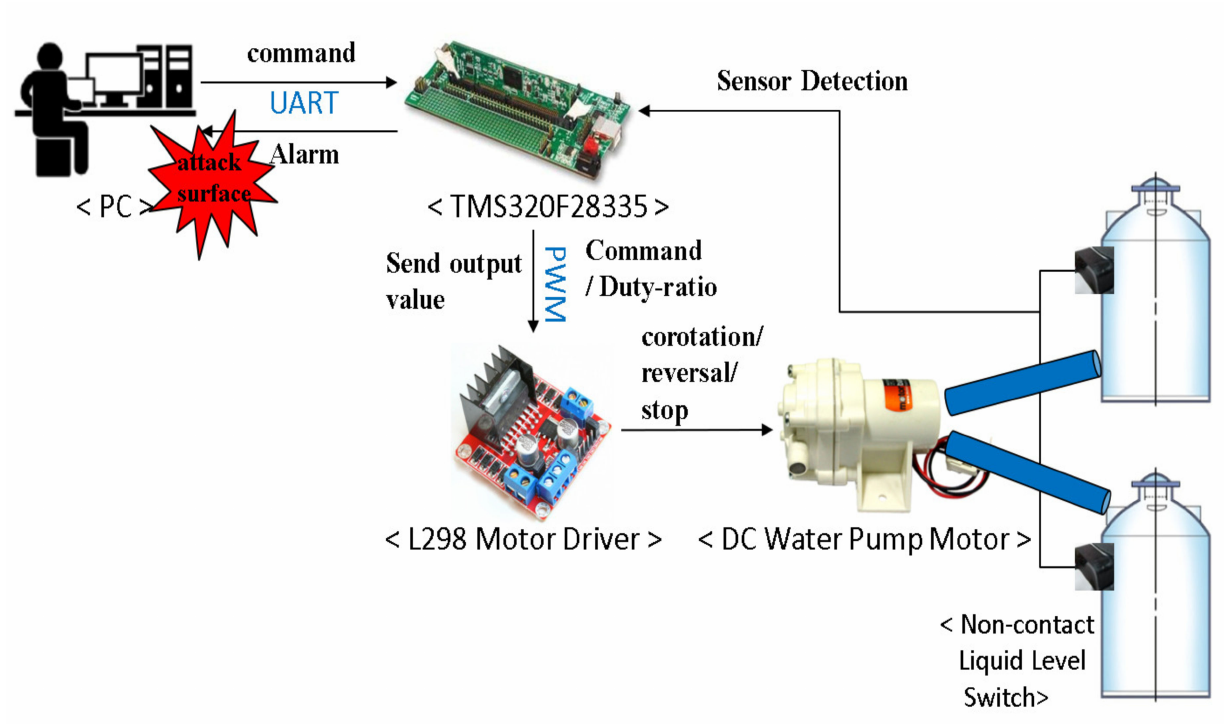
Figure 6. Configuration of the testbed.